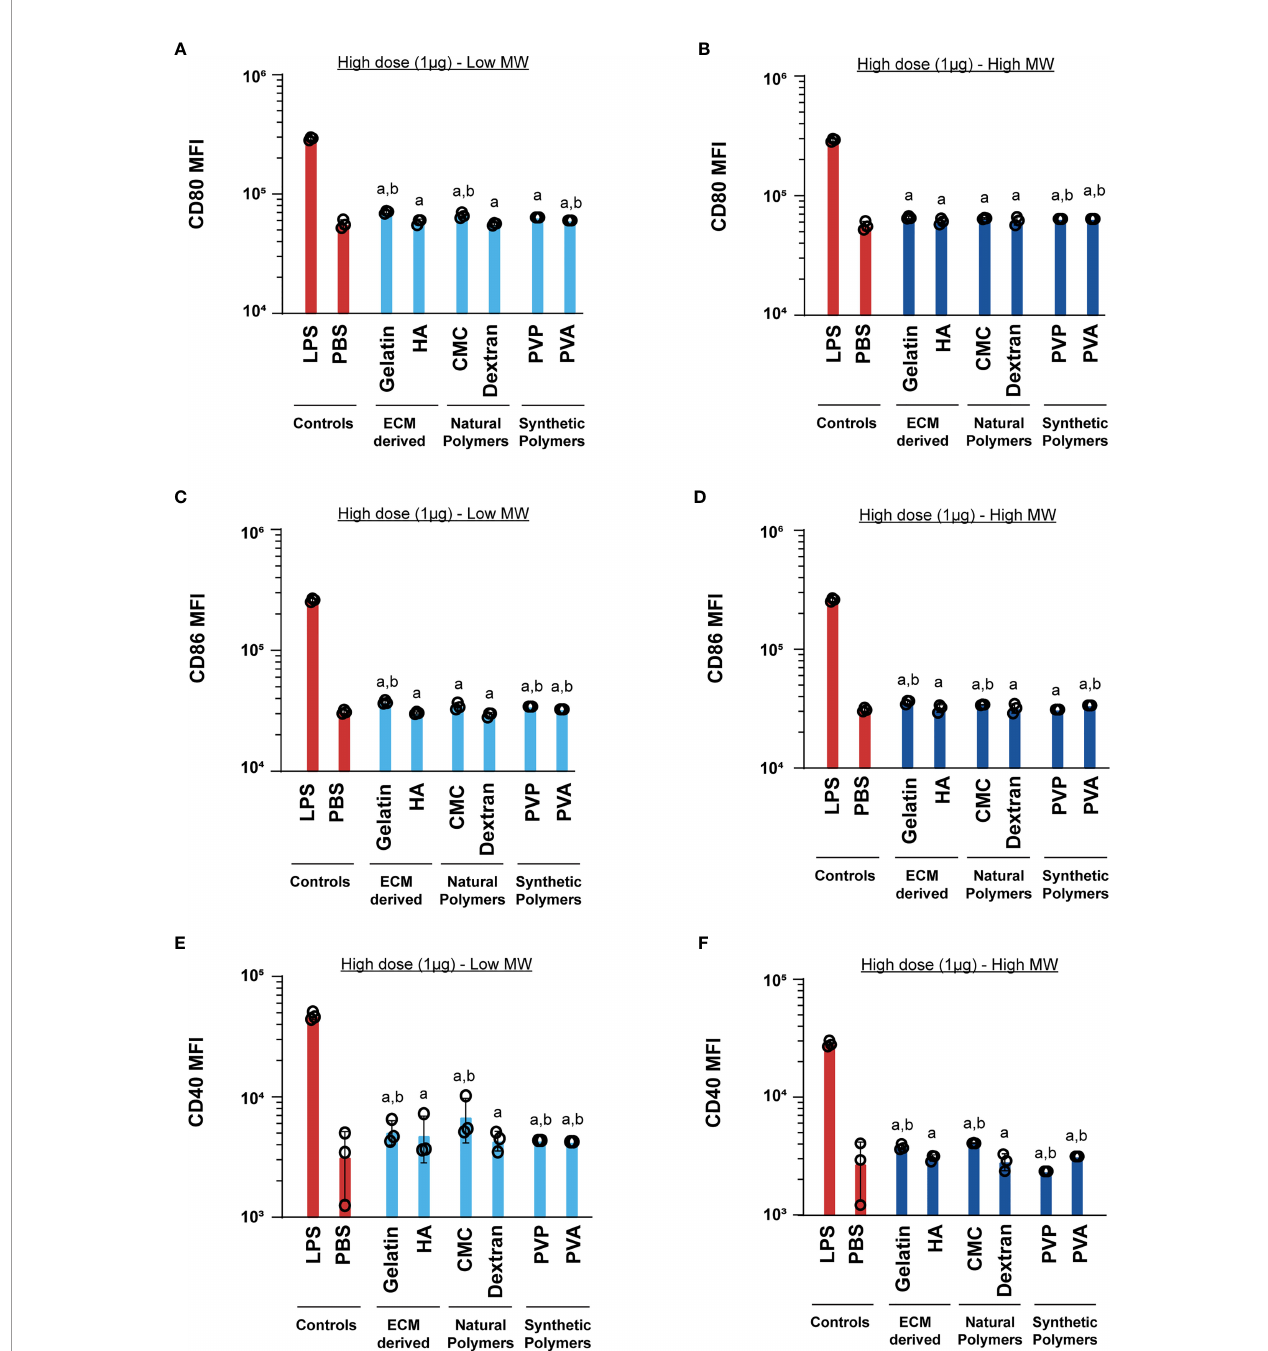
FIGURE 5 | High (1 m g) dose of both high and low MW polymers leads to activation similar to the negative control. Activation of DCs treated with low or high MW polymers at high doses, respectively, as indicated by expression of (A, B) CD80, (C, D) CD86 and (E, F) CD40. “ a ” and “ b ” represents signi fi cant statistical differences (p < 0.05) when compared with LPS and PBS group